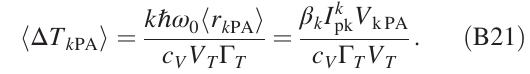
FIG. 11. Approximate spectrum of microcavity noise sources for the experimental parameters in Table I. Note that S 1 = 2 ffiffiffiffiffiffi p fractional stability (units 1 = Hz to aid comparison with cavity stabilization literature). Noises from two-photon absorption (2PA) and self-phase modulation (SPM) at their respective nonlinear threshold powers — which approximates the maximum noise level — are still smaller than